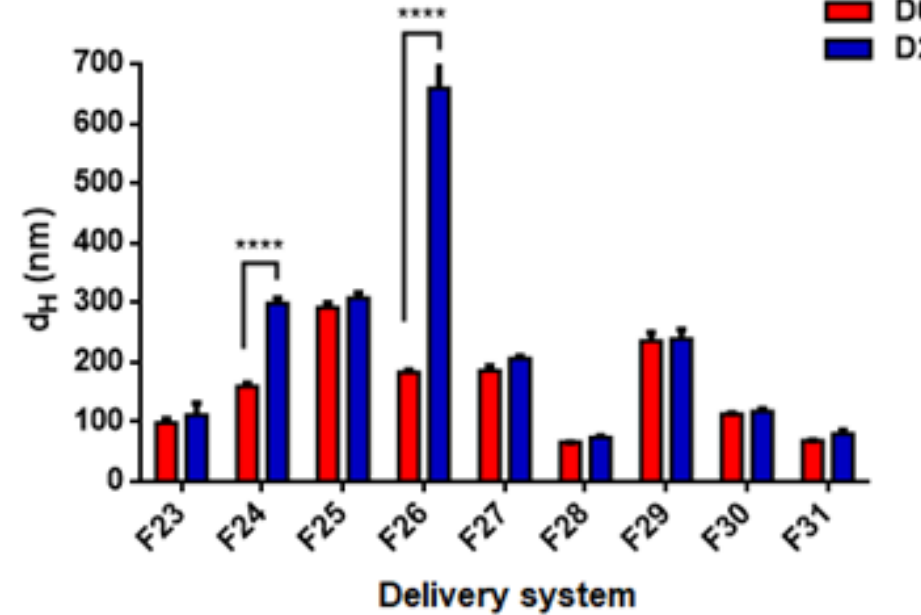
Figure 10. Effect of storage time on the stability of TA EO nanoemulsions (formulations F23–F27) and nanoparticles (formulations F28–F31). Statistical significance: **** p < 0.0001 (highly significant). Legend: day 0 (D0), day 60 (D60).